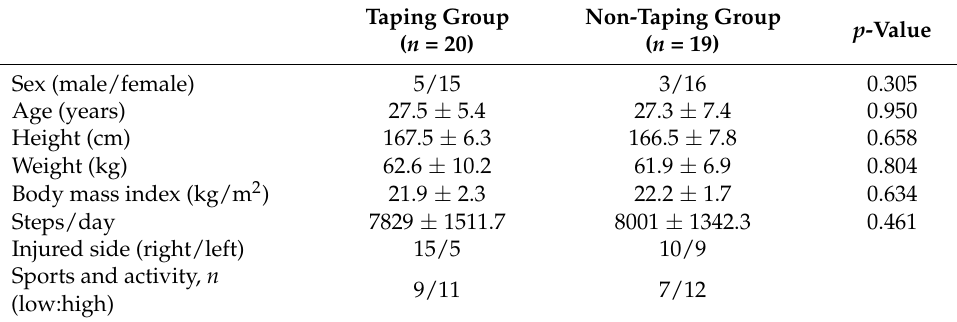
Figure 1. Study flow diagram. Table 1. Demographic data of enrolled patients.